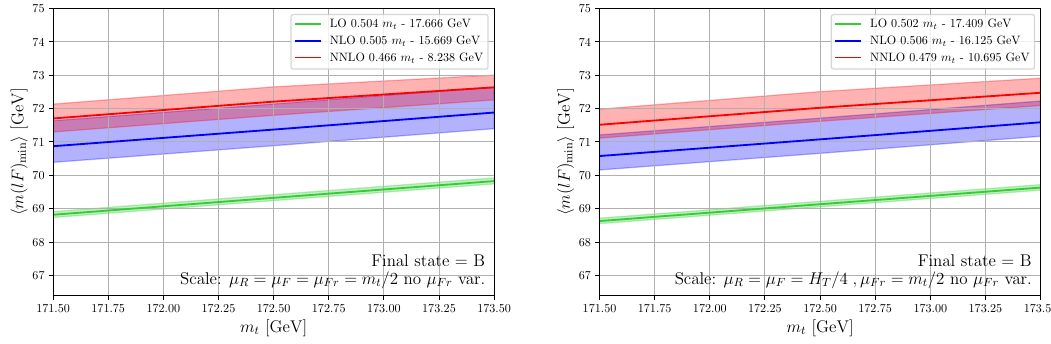
Figure 15 . The first moment of the normalized m ( B‘ ) min distribution computed with two different scales: fixed scale (3.2) (left) and the dynamic scale (3.3) (right). In both cases bands correspond to 7-point scale variation with fixed µ Fr